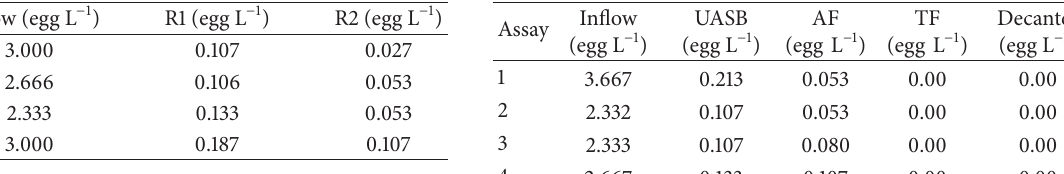
Table 6: Results of the average numbers of Ascaris suum eggs obtained in the samples of crude inflows and effluents of the UASB reactors (R1) and (R2) placed in series, at pilot scale, of treatment system I, in assays 1, 2, 3 and 4.